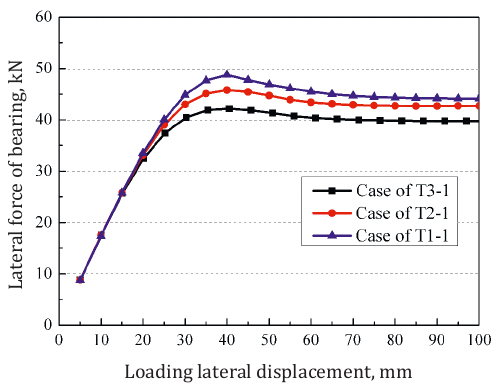
Loading lateral displacement, mm Figure 7. Comparisons of horizontal force-displacement curves under anchor connection at both ends